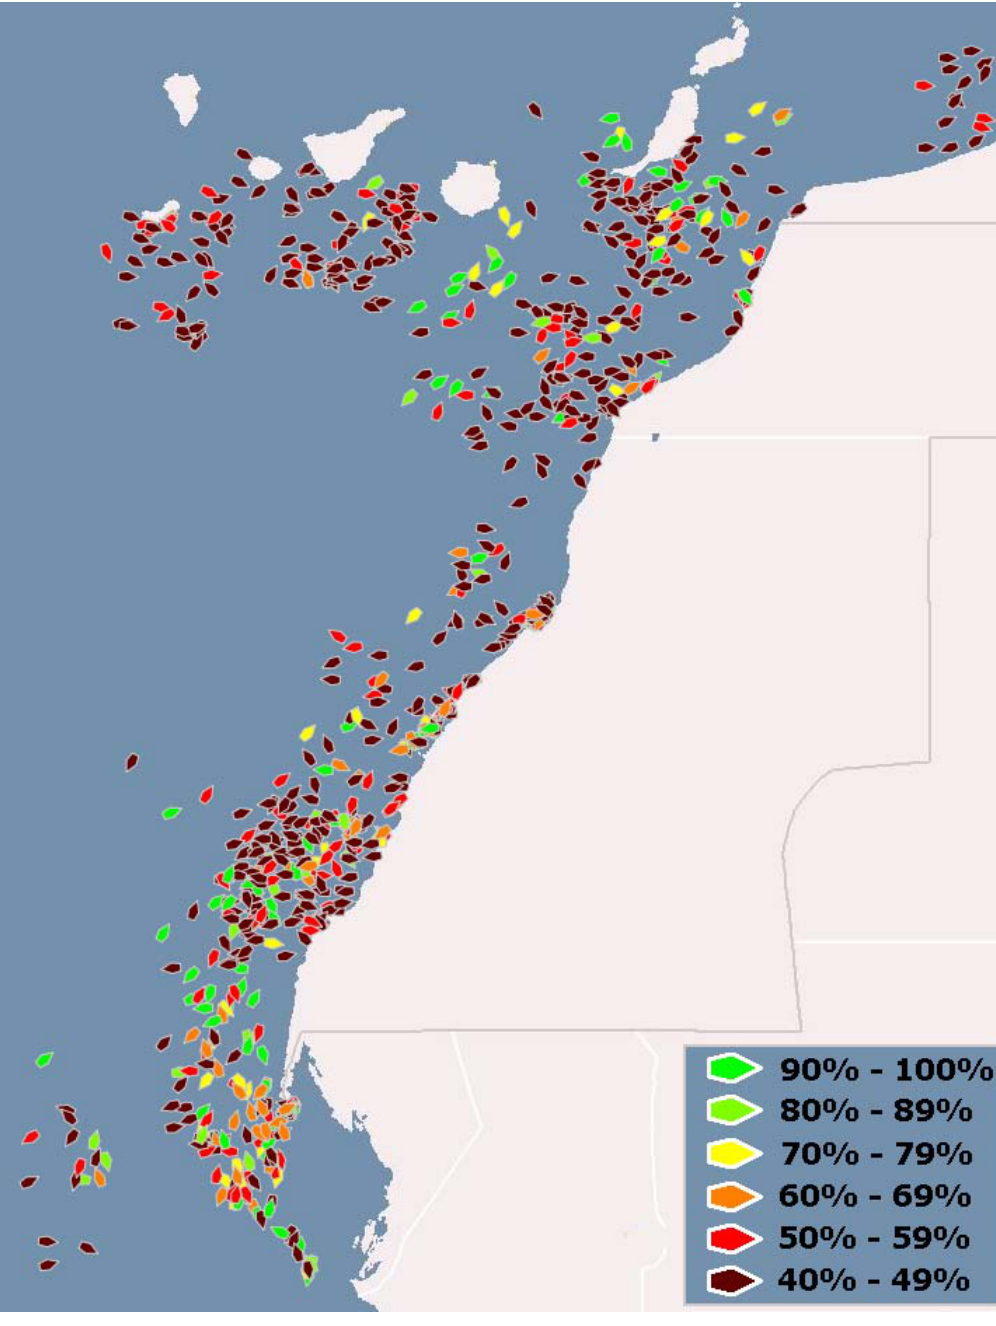
Figure 12. Detection results for the datasets shown in Figure 10. Color code indicates the level of confidence.